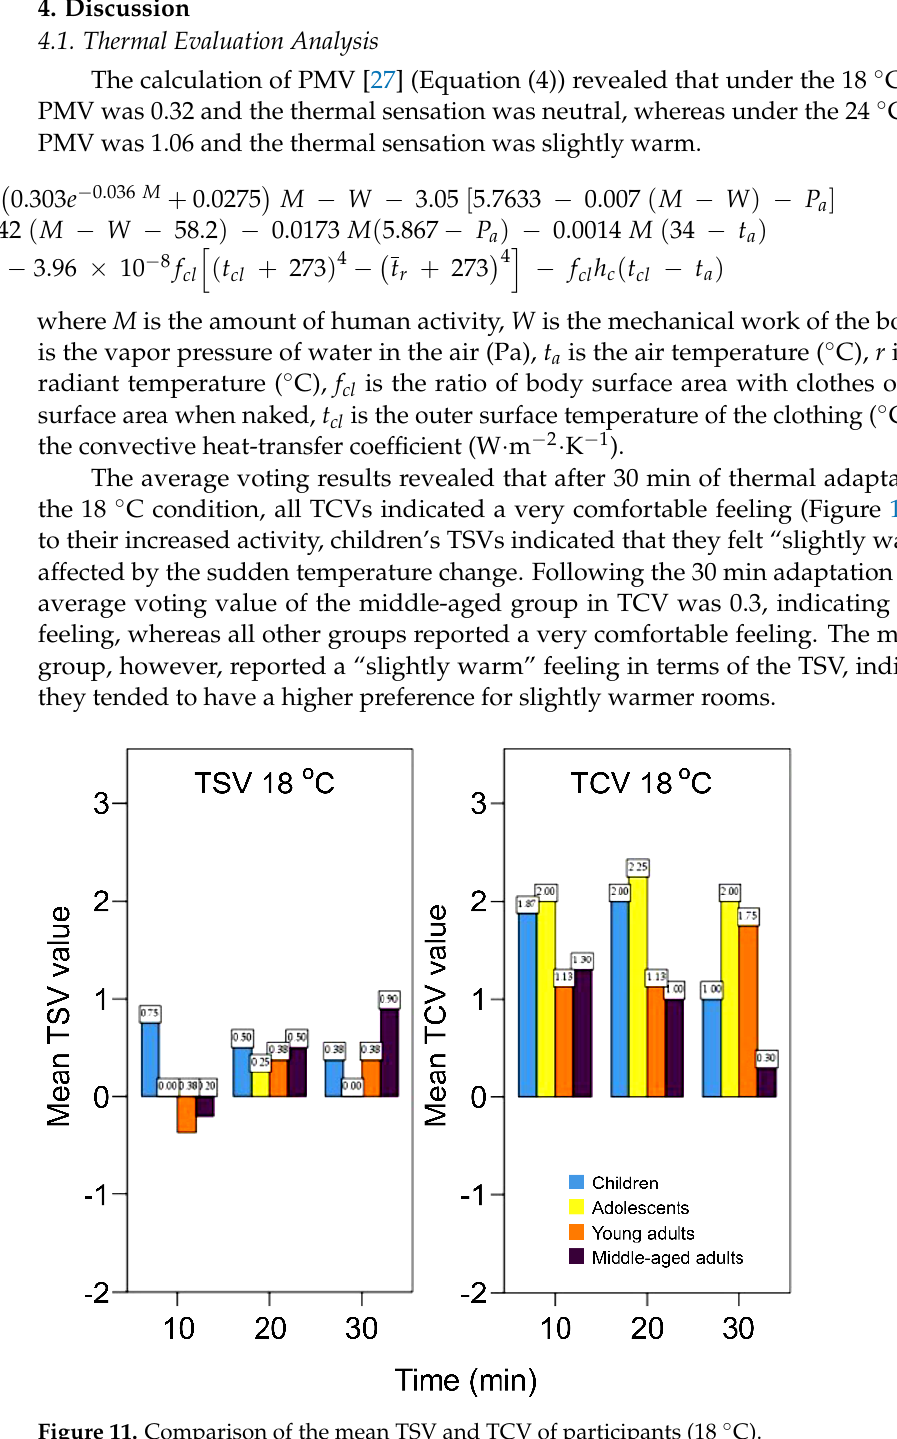
Figure 12. Comparison of the mean TSV and TCV of participants (24 °C). 4.2. Thermal Expectation Analysis Frequency distributions of the thermal expectation votes for the participants in the two conditions were compared, revealing that under the 18 °C condition, >80% of the participants in all age-group s voted to “stay at the current temperature” when expressing